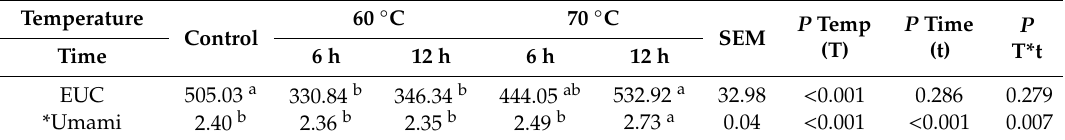
Table 5. EUC (mg MSG / g) and umami taste (mV) of beef semitendinosus heated at di ff erent temperatures and